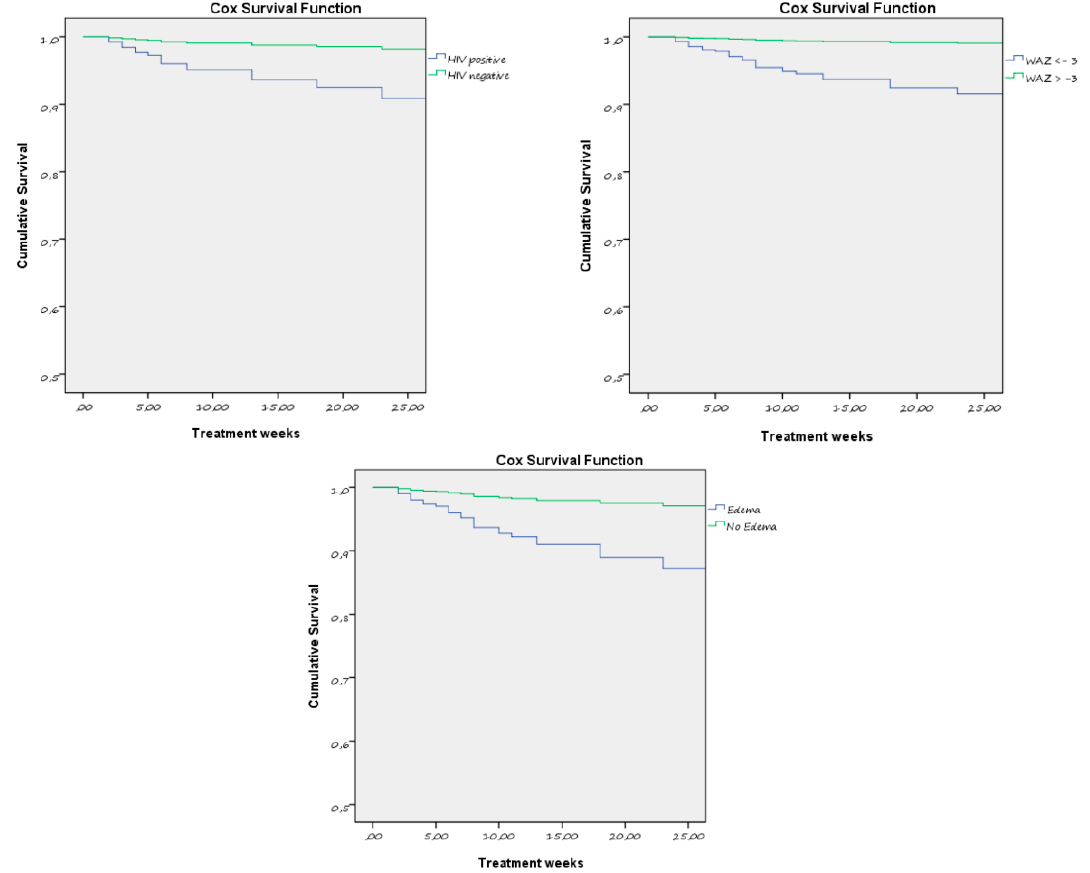
Figure 2. The Cox survival analysis. The outcome of death by HIV status, weight for age z-score, and kwashiorkor at baseline.